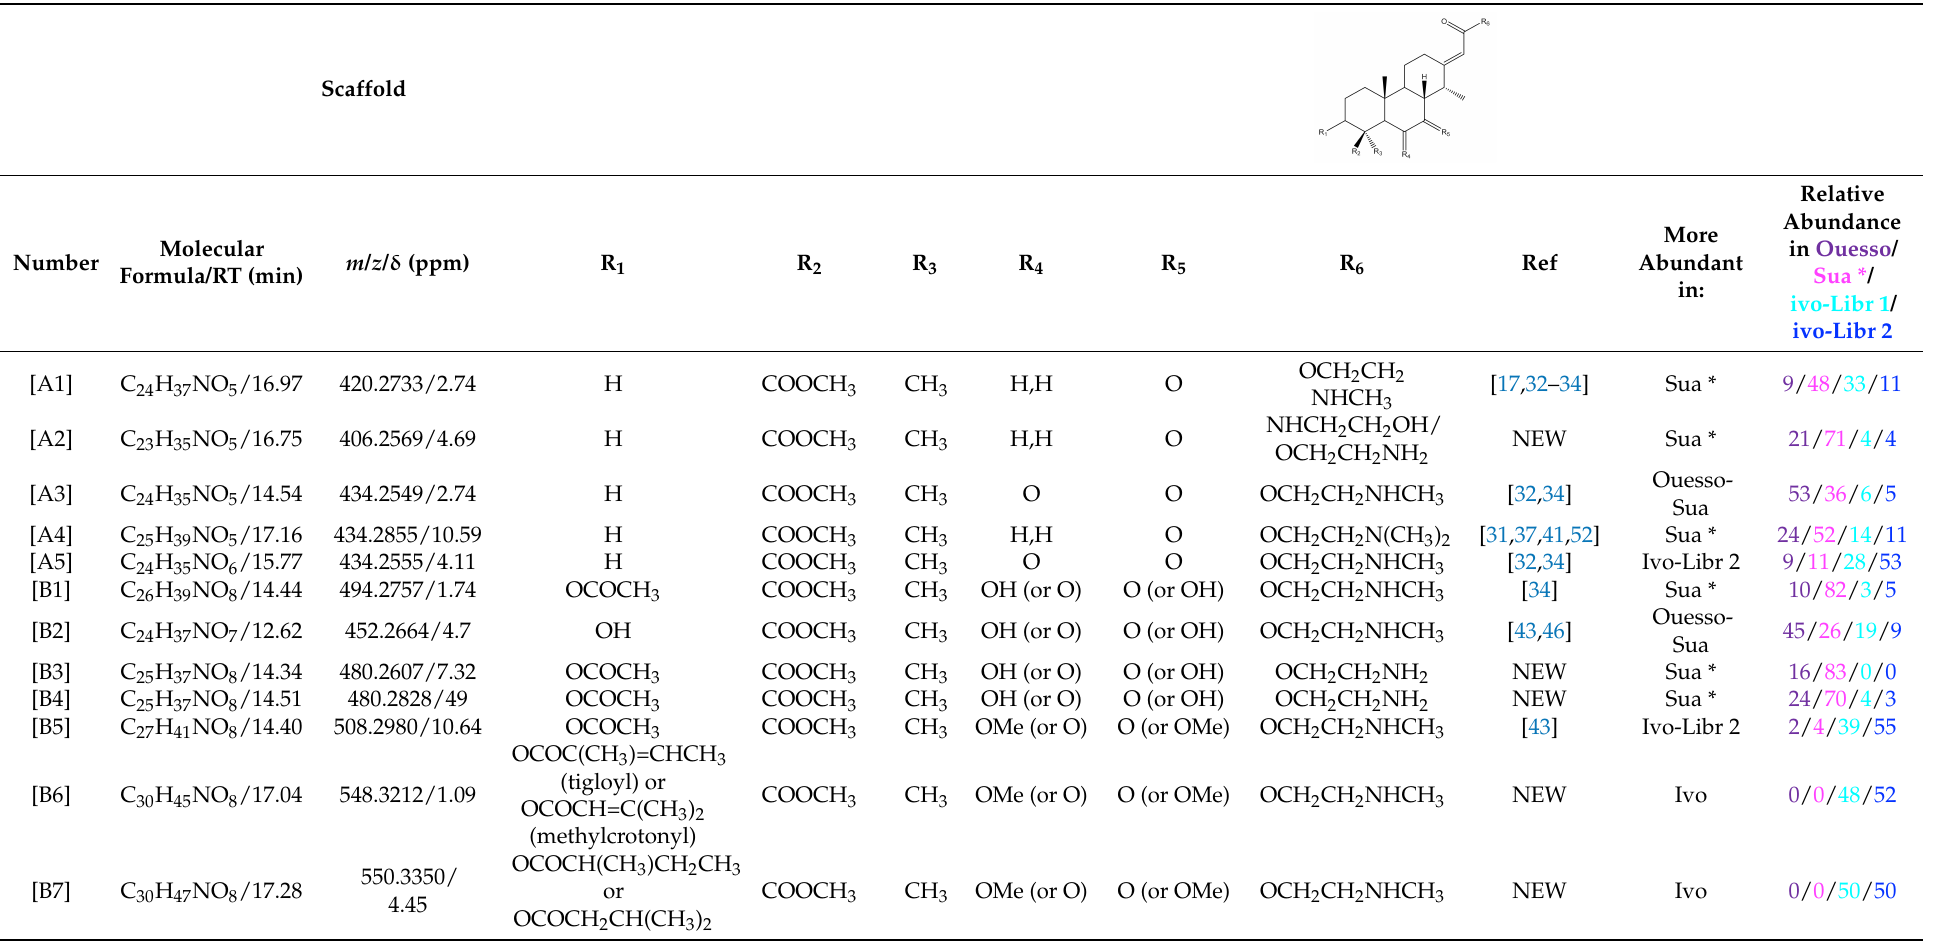
Table 2. Molecular assignment details of the 28 features identified in cassane-diterpene cluster by molecular network (see Figure 7). The color in the last column are: Sua * in